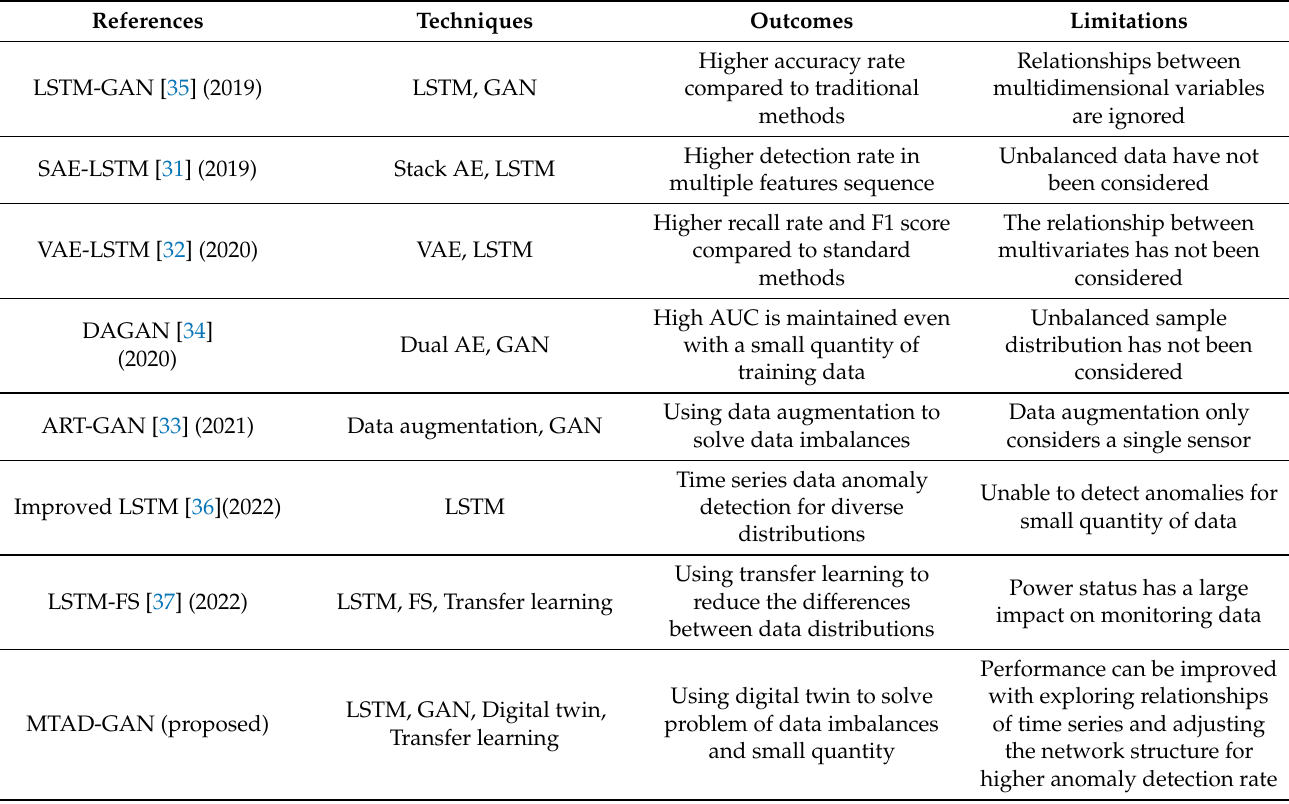
Table 2. Comparative Analysis of the proposed deep learning scheme with related